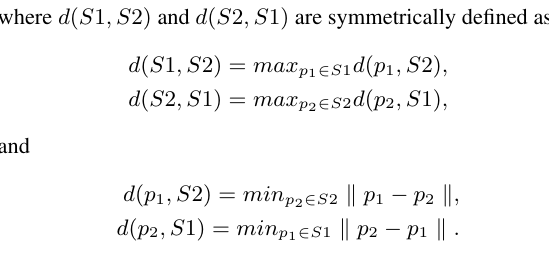
Figure 1: Hausdorff distance for two point sets A and B . ( a ) The point sets. (b) Computation of the Euclidean distance from each element of the set A to each point of B (values in white re- fer to the thicker arrow corresponding to the minimum distance). (c) Computation of the Euclidean distance from each element of the set B to each point of A (values in white refer to the thicker arrow corresponding to the minimum distance). (d) Maximum distances between sets. (e) Hausdorff distance between set A and B: d H ( A, B ) = 2 . 32